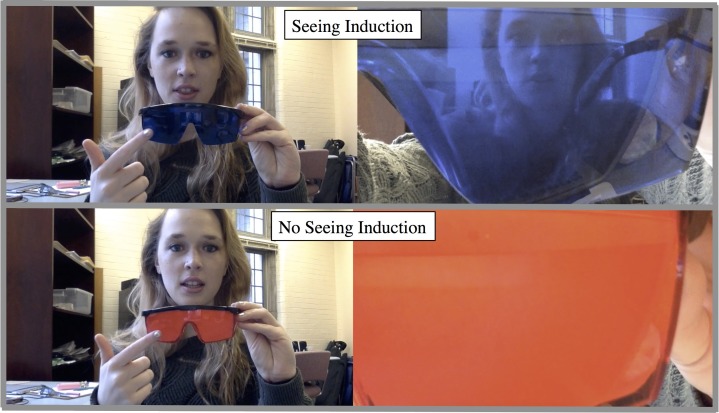
Depiction of belief induction event.The entire belief induction event was a video presented to participants online. The individual in this manuscript has given written informed consent (as outlined in PLoS consent form) to publish this image.